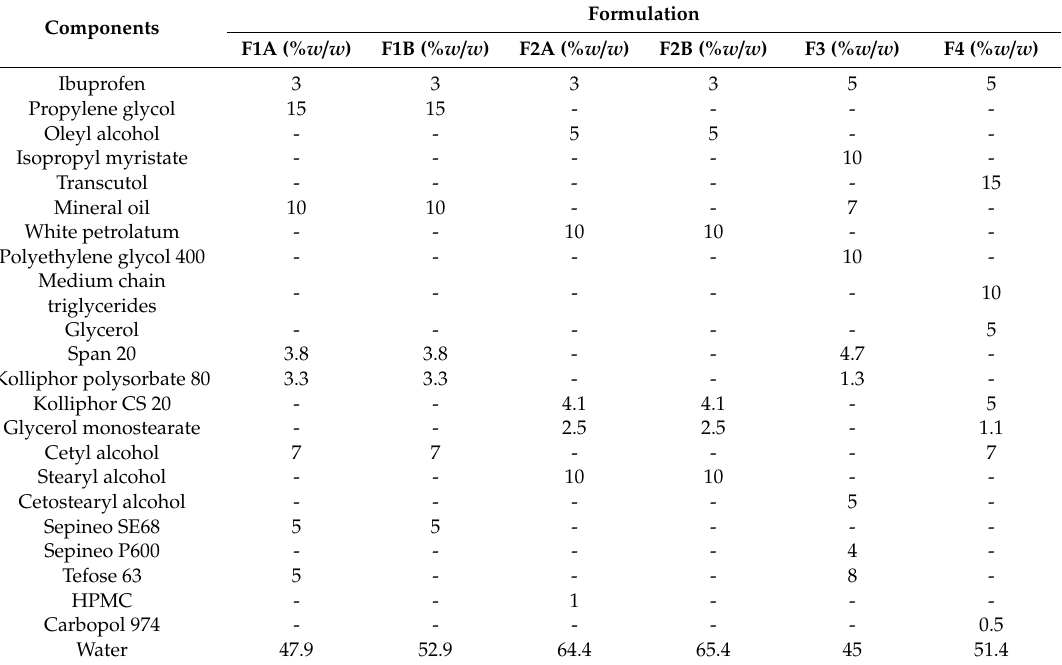
Table 1. Composition of optimized creams in the study.